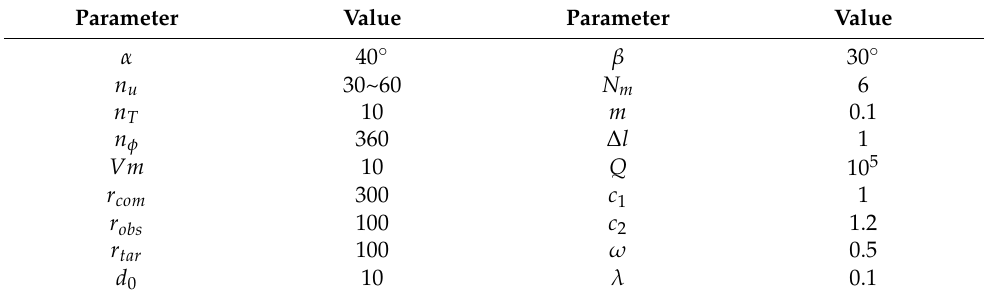
Table 2. Parameter values.